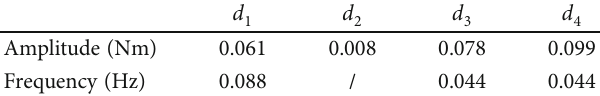
Table 2: Theoretical results of case 1.